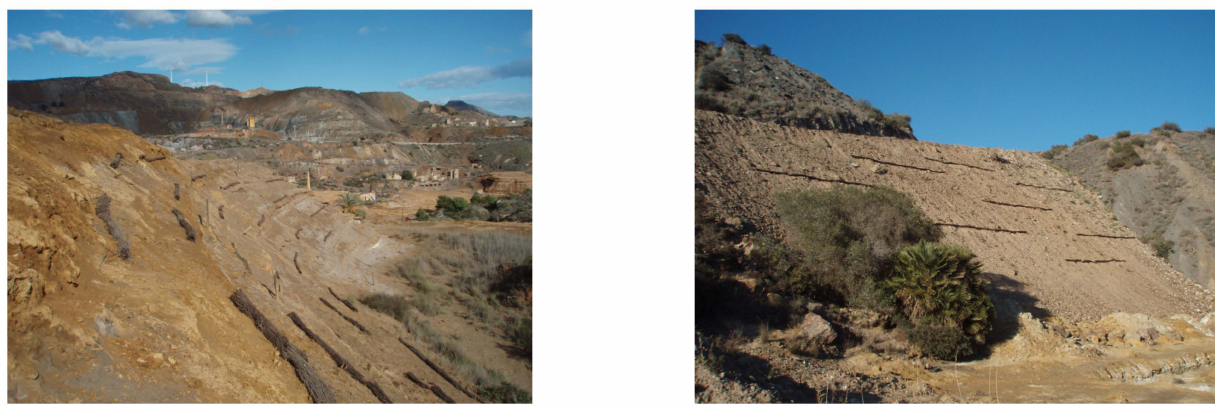
Figure A10. Planting plan for the stabilization of slopes of Case Study 1.